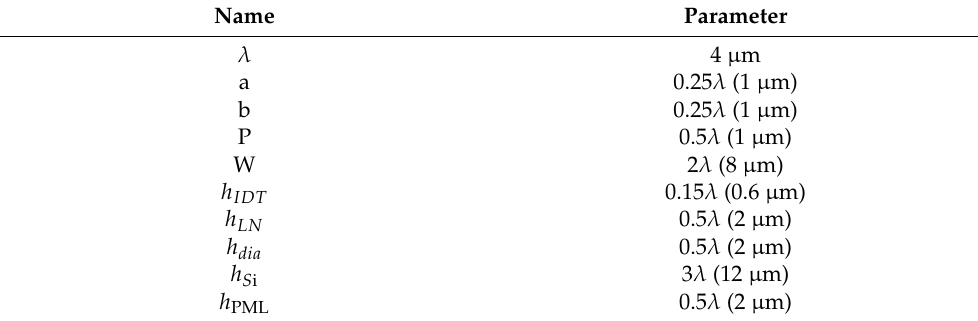
Table 3. Initial structural parameters of simulation model.